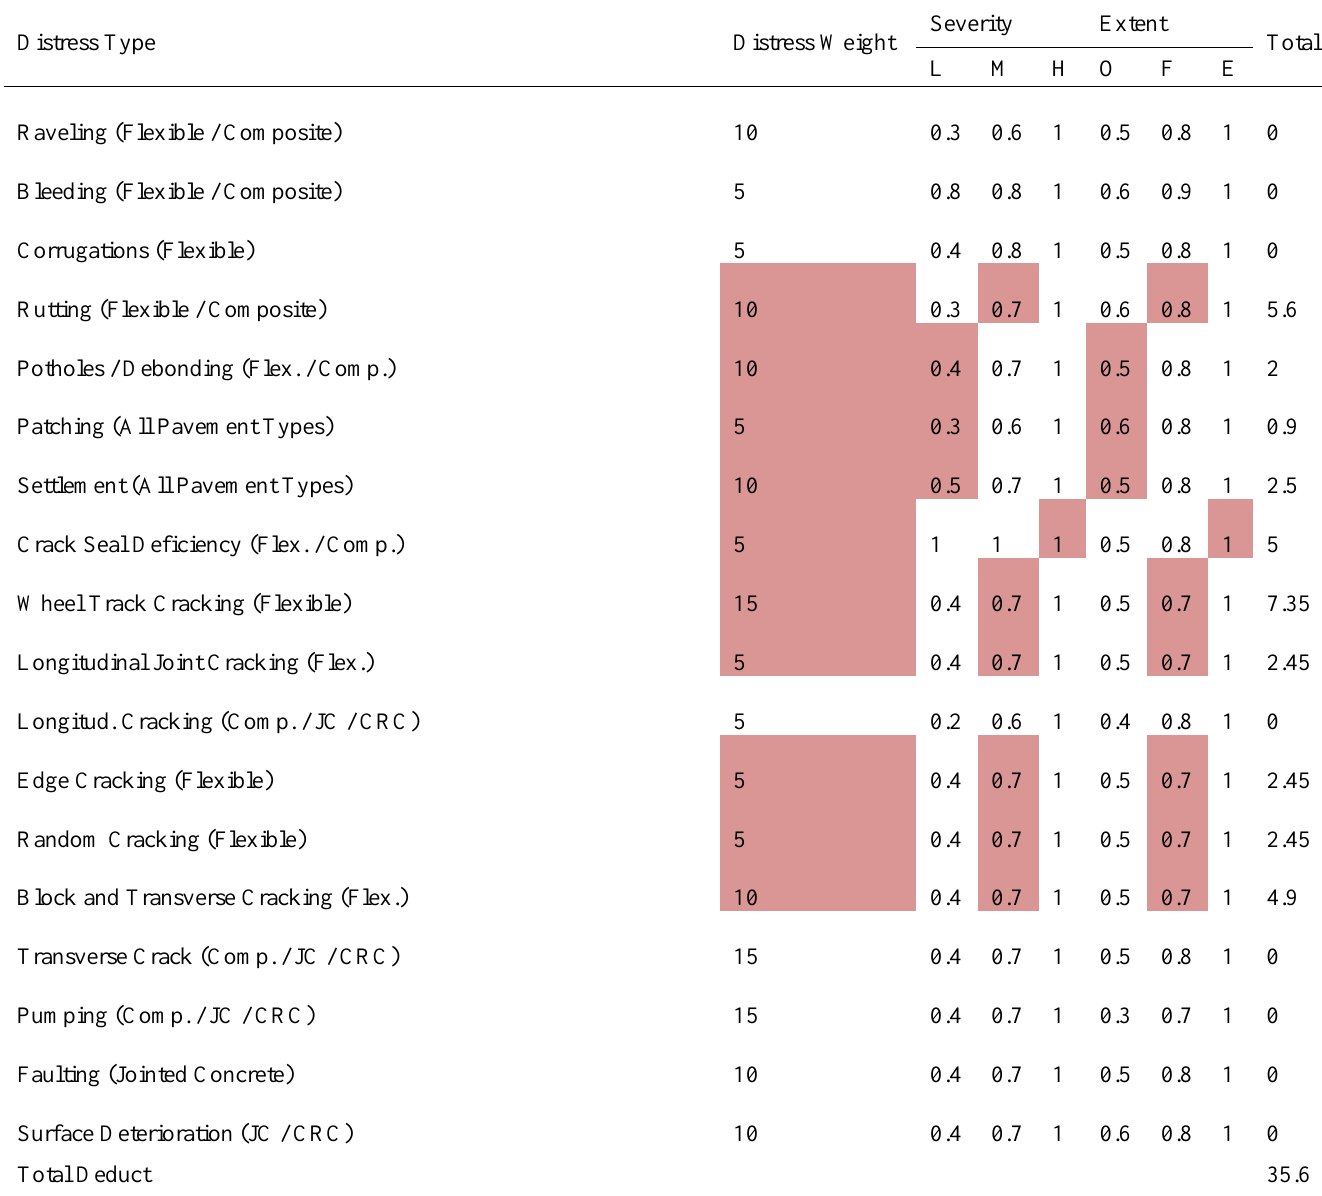
PCR values Reprinted from “Pavement condition rating form” by Angela Wolters and Kathryn Zimmerman, Implementing Pavement Management Systems for local agencies, 2011 illusion center for transportation series no. 11-094 pp. 63, Fig.